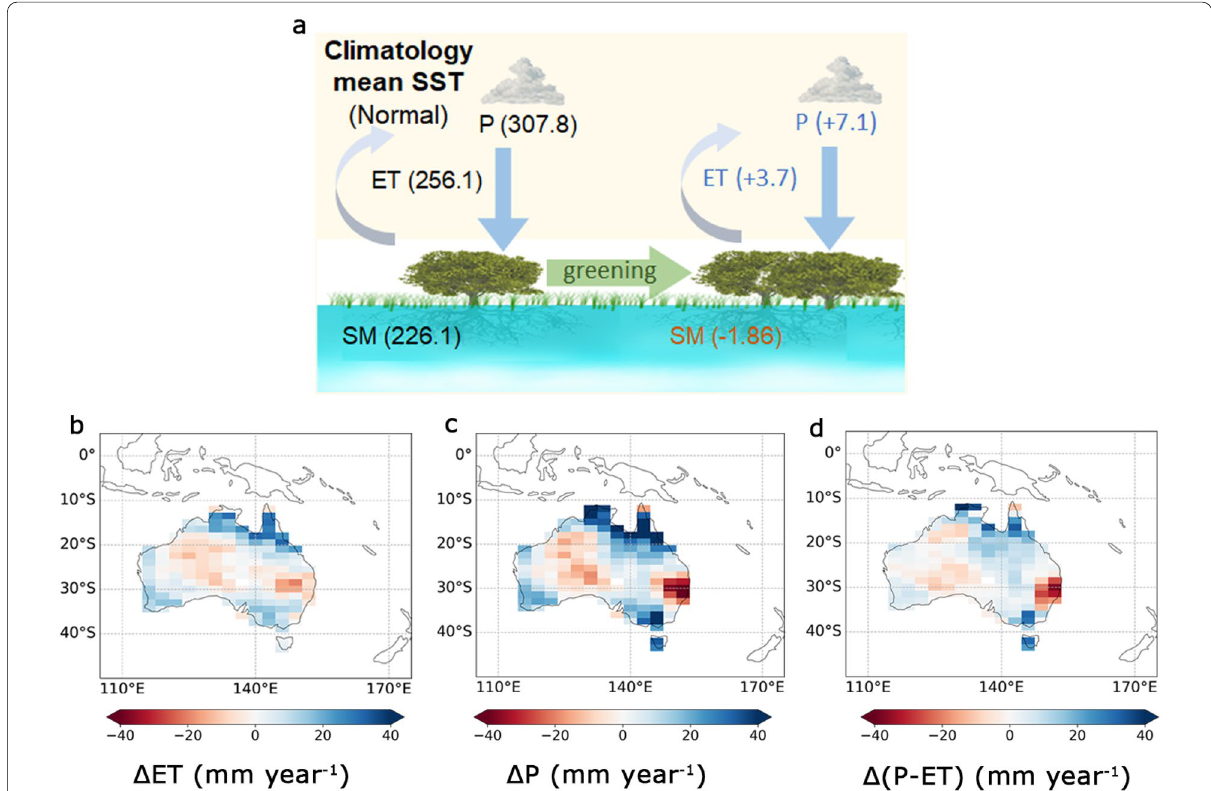
Fig. 4 Conceptual illustration and the spatial patterns of the modeled changes in water yield under greening for mean SST forcing. a The biosphere–atmosphere iterations before and after greening for hydrological balance variables ET (mm year − 1 ), precipitation (P, mm year − 1 ), and soil moisture (SM, mm). Flux is illustrated by upward (downward) arrows. The blue values indicate the increase (decrease) amount of the flux. The numbers represent changes in the variables. b – d The spatial patterns of the changes in ET, P, and water yield (P-ET) under